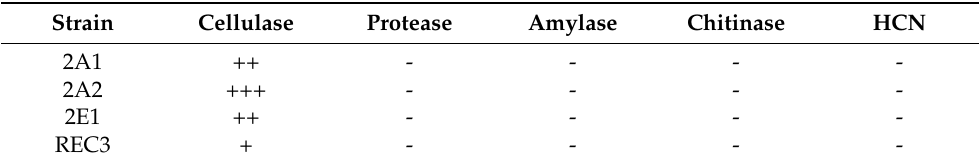
Table 1. Enzymatic activities of the four strains of A. brasilense .